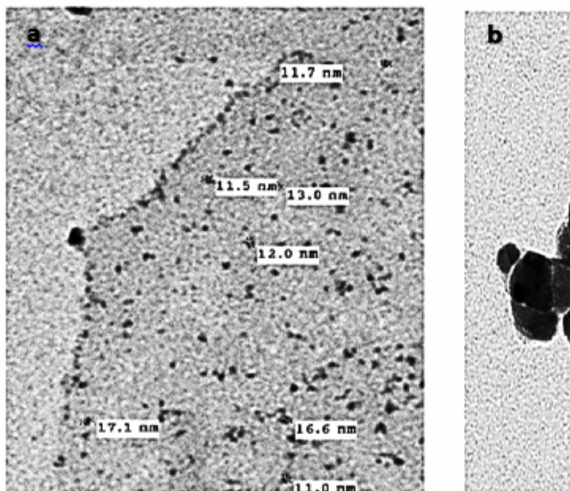
Figure 1. ( a ) Photo of S. paucimobilis cultures with 0.025 mol/L TiO absorption spectra of TiO